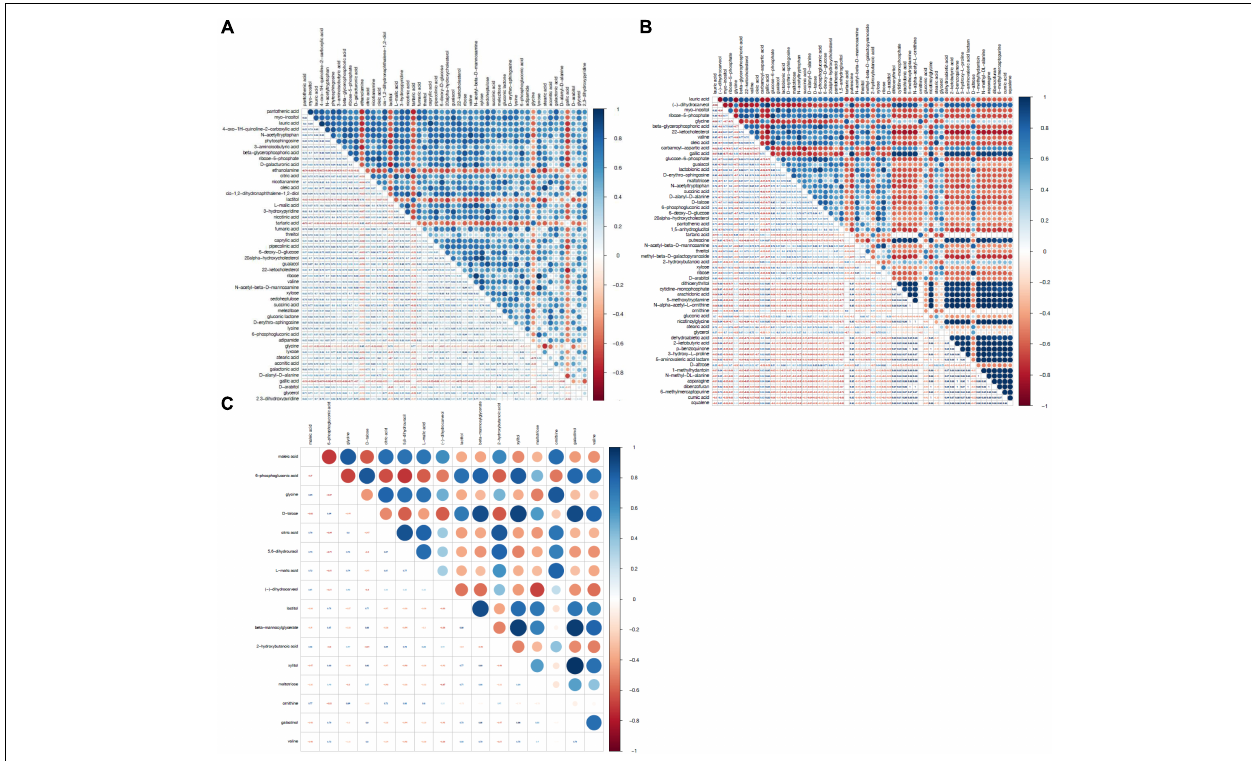
FIGURE 5 | The correlation analysis between differential metabolites in Mycelia B samples and Mycelia A samples (A) , Mycelia C samples and Mycelia A samples (B) , and Mycelia C samples and Mycelia B samples (C) . Blue color represents positive correlation, while red color represents negative correlation (see color scale). The value which is larger demonstrates the greater correlation between the two